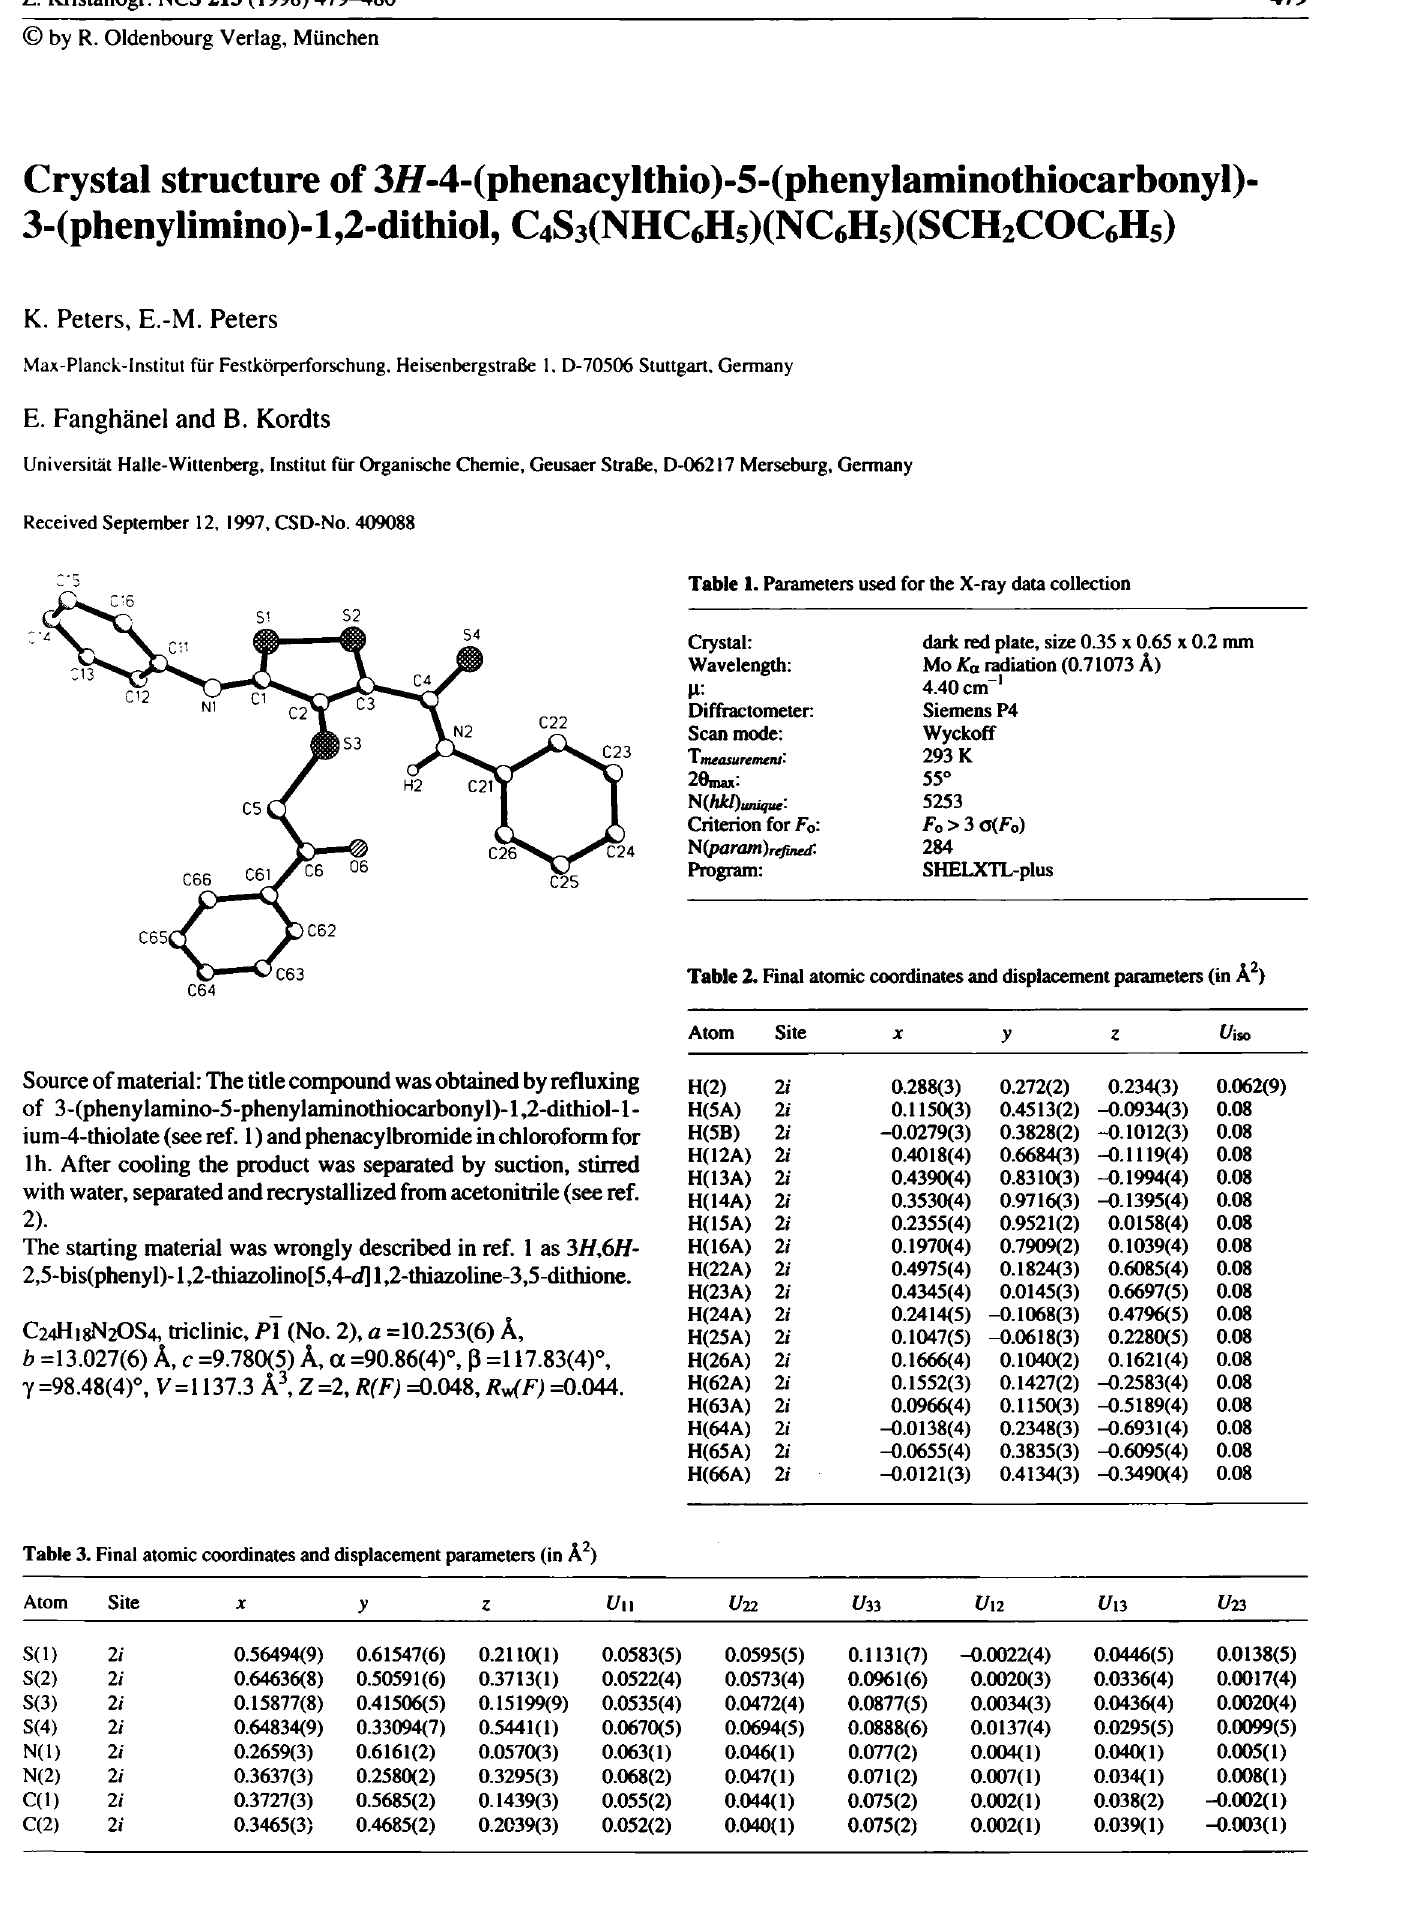
Table 3. Final atomic coordinates and displacement parameters (in Â^)